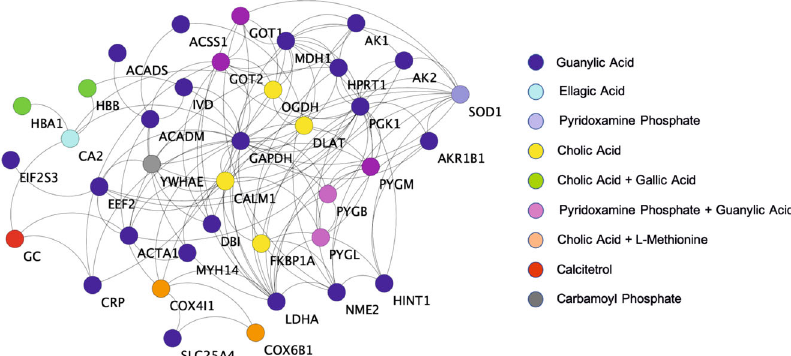
Fig. 4 Synergistic action of AR metabolites on target proteins. The color codes on the proteins/targets in the interaction network indicate their corresponding metabolites identi fi ed after screening using SMSD and Tc. Blue circles represent the proteins corresponding to guanylic acid (the maximum in number), followed by yellow color for cholic acid. ellagic acid is represented by cyan color, whereas calciterol by red circles. Gray color circles correspond to carbamoyl phosphate and purple to pyridoxamine phosphate. Noradrenaline sulfate metabolite corresponds to light blue circled proteins. Few proteins correspond to more than one metabolite and are represented as orange circled proteins for the combination of cholic acid and L-methionine, and green circles for cholic acid and gallic acid. The pink circles are proteins corresponding to pyridoxamine phosphate and guanylic acid. All these proteins are interconnected and have a signi fi cant role in the disruption or regulation of pathways as seen when knocked out from the network. This observation suggests the co-dependency of AR metabolites for the maintenance of the protein – protein interaction network, which is vital to drug action, thereby af fi rming their synergistic